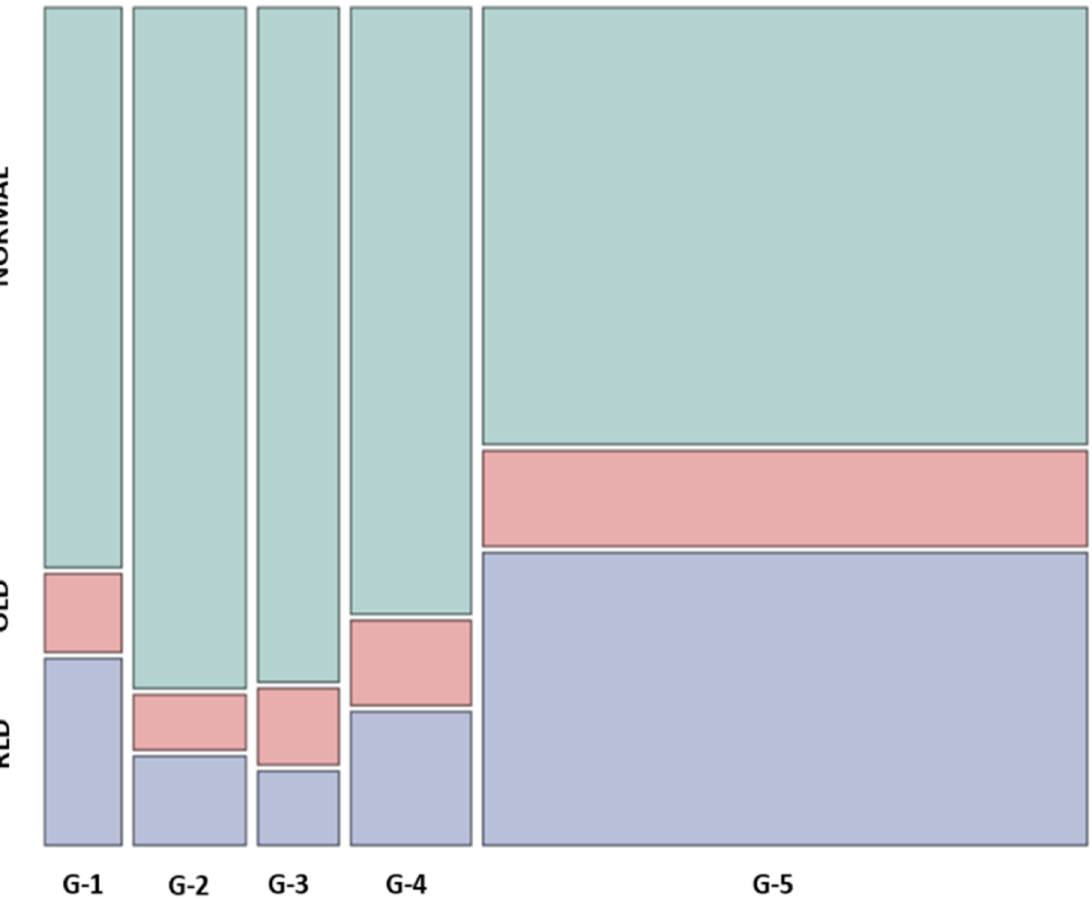
Fig 1. Prevalence of normal lung function, OLD and RLD in 404 individuals according to GFR categories 1–5. Chi square = 29.9, p < 0.001. Abbreviations: OLD; obstructive lung disorder FEV1/FVC < 0.70, RLD; restrictive lung disorder, FEV1/FVC (cid:21) 0.70 and %FVC < 80. G-1 through G-5 are GFR categories: Normal (G1; n = 31; GFR > 90mL/min/1.73 m2) or only mildly decreased (G2; n = 46) GFR, significant reductions of GFR, G3 (n = 33) and G4 (n = 49), and patients with kidney failure, G5 (n = 245; GFR < 15mL/min/1.73